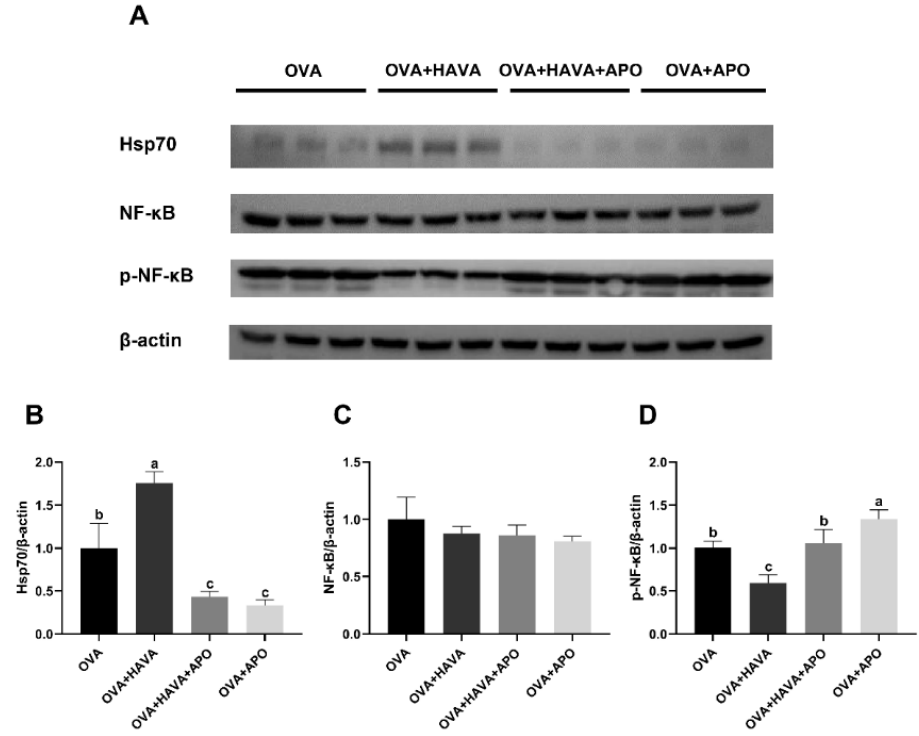
Figure 5. The Hsp70-NF- κ B signaling in the jejunum of mice in experiment 2. ( A ) Protein expressions of heat shock protein 70 (Hsp70), nuclear factor kappa-B (NF- κ B), phosphorylated-NF- κ B (p-NF- κ B), and β -actin in the jejunum, ( B – D ) Western blot quantitative data of Hsp70, NF- κ B and p-NF- κ B in the jejunum. OVA: mice orally challenged with OVA; OVA + HAVA: an OVA challenged group that was oral gavaged with a high dose of 20 mg/kg bw avenanthramide (AVA); OVA + HAVA + APO: the OVA + HAVA group coupled with apoptozole (APO); OVA + APO: the OVA group coupled with APO. Results are presented as means ± SDs ( n = 3). Bars with no letter in common are significantly different, p ≤